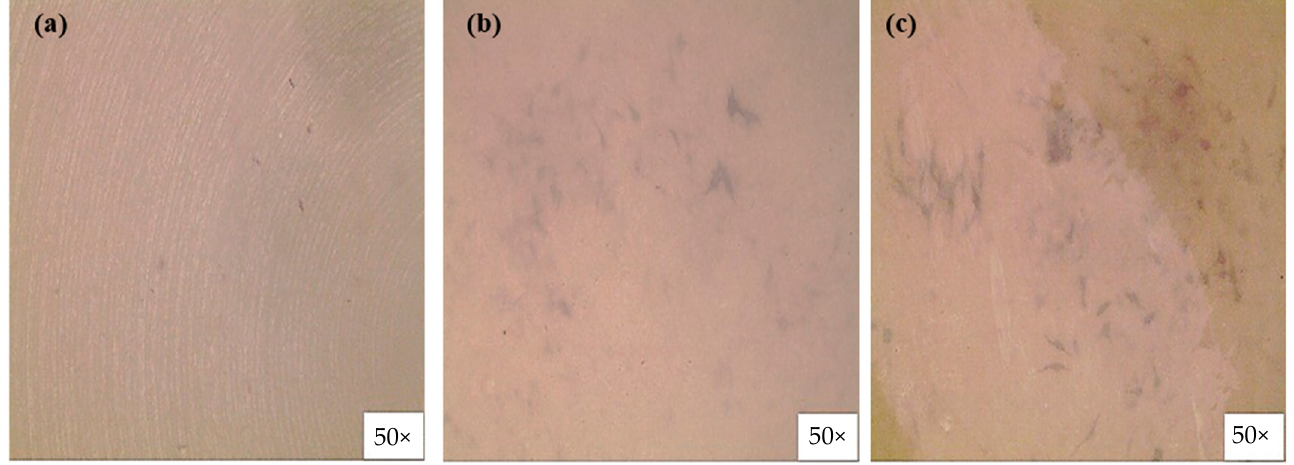
Figure 9. Alkaline phosphatase activity staining of MC3T3-E1 cells cultured for 14 days on pristine PEEK ( a ), P-PEEK ( b ), and P-PEEK-Col ( c ).